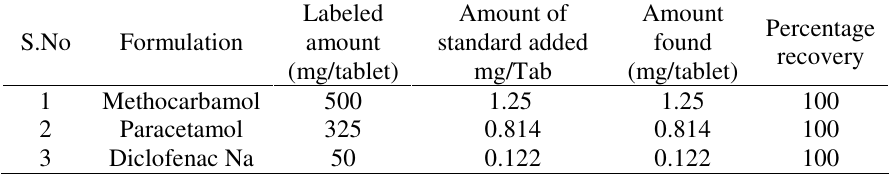
Table 7. Results for recovery analysis